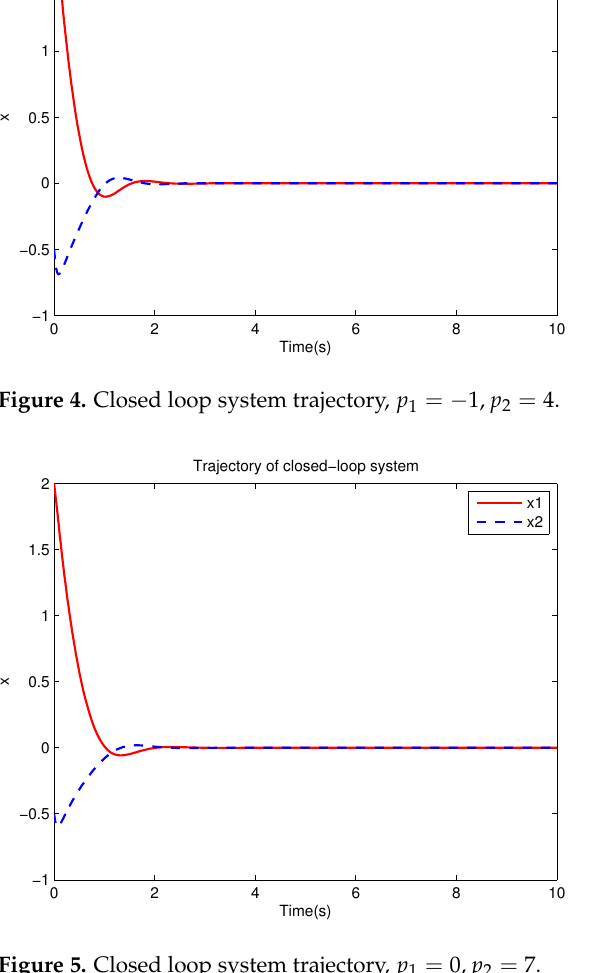
Figure 5. Closed loop system trajectory, p 1 = 0, p 2 = 7.